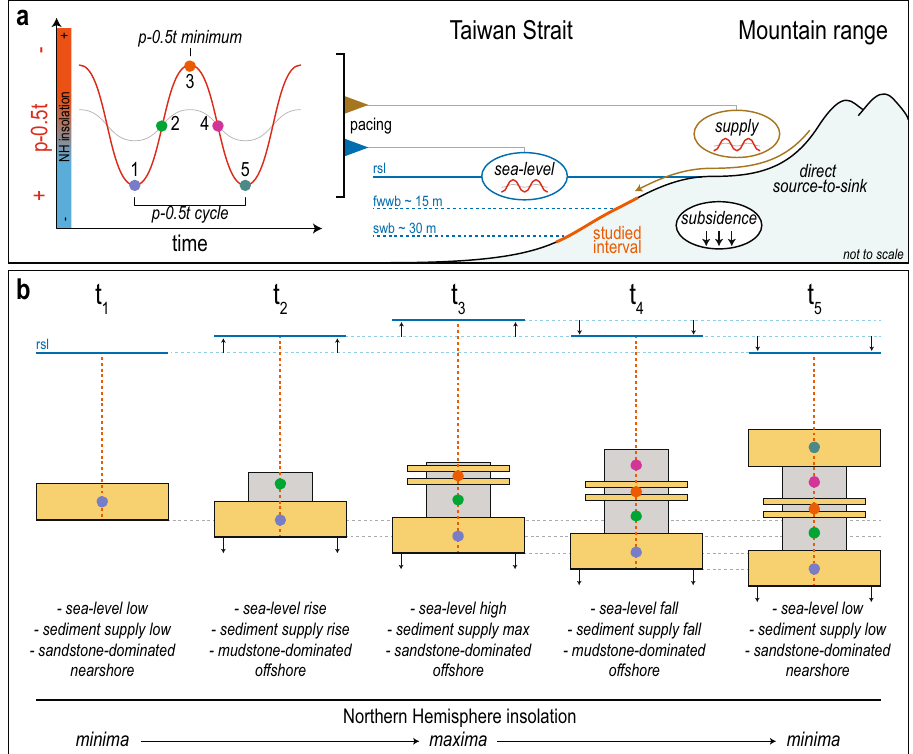
Figure 4. ( a ) Conceptual model of depositional cyclicity recorded in the lower Cholan Formation. The three main actors that influence deposition are sea level, sediment supply, and subsidence (red curve: large amplitude p-0.5t cycle; gray line: low amplitude p-0.5t cycle). ( b ) While subsidence is considered continuous, sea level and sediment supply fluctuated following the Northern Hemisphere (NH) insolation (p-0.5t curve), which is dominated by precession (Fig. 3). When the NH insolation increases (1 to 2), sea level rises due to the partial melting of NH ice sheets, and sediment supply increases through the coupled action of tropical cyclones and monsoons. The NH insolation maximum (3) relates to the highest sea level and the climax of the coupled tropical cyclones and monsoons, which are preserved as an increase of sand exported into offshore environments. Next, the NH insolation decreases (4), and sea level falls and decreases sediment supply (4). The lowest points of both sea level and sediment supply are reached when summer insolation of the NH is minimum. rsl: relative sea level; fwwb: fairweather wave base; swb: storm wave base. The illustration was made using Adobe Illustrator CS6 (https:// www. adobe.